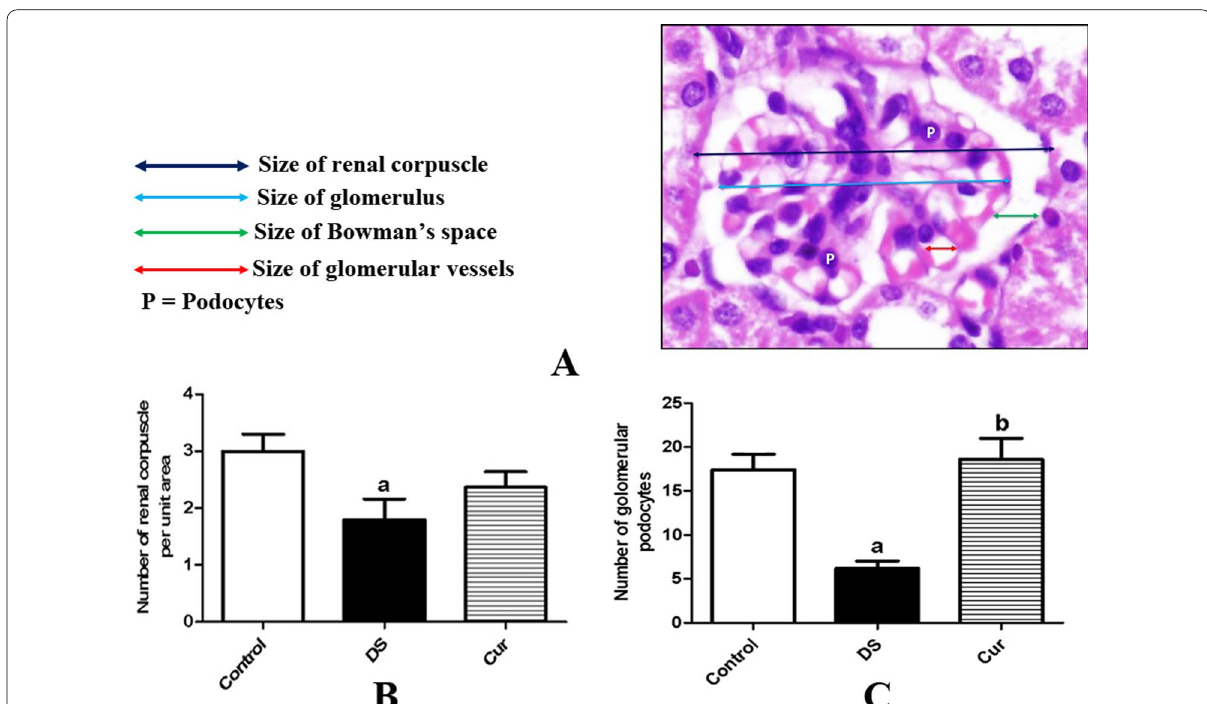
Fig. 4 A Photograph showed the measured morphometric parameters in the renal corpuscles. B Histogram showed that the number of the renal corpuscles per unit area significantly decreased in diclofenac sodium (DS) group compared to the control (Ctrl) group, and curcumin (Cur) restored the number of renal corpuscles to normal. 3C: Histogram showed that the number of glomerular podocytes significantly decreased in DS group while oral supplementation of Cur prevented this decrease and kept the normal number of glomerular podocytes. Results are expressed as mean SEM (6 mice/group). Data are analyzed by one‑way ANOVA followed by Duncan posttest. a indicates significant difference between control ± and DS groups at p < 0.05; b indicates significant difference between DS and DS Cur groups at p < +